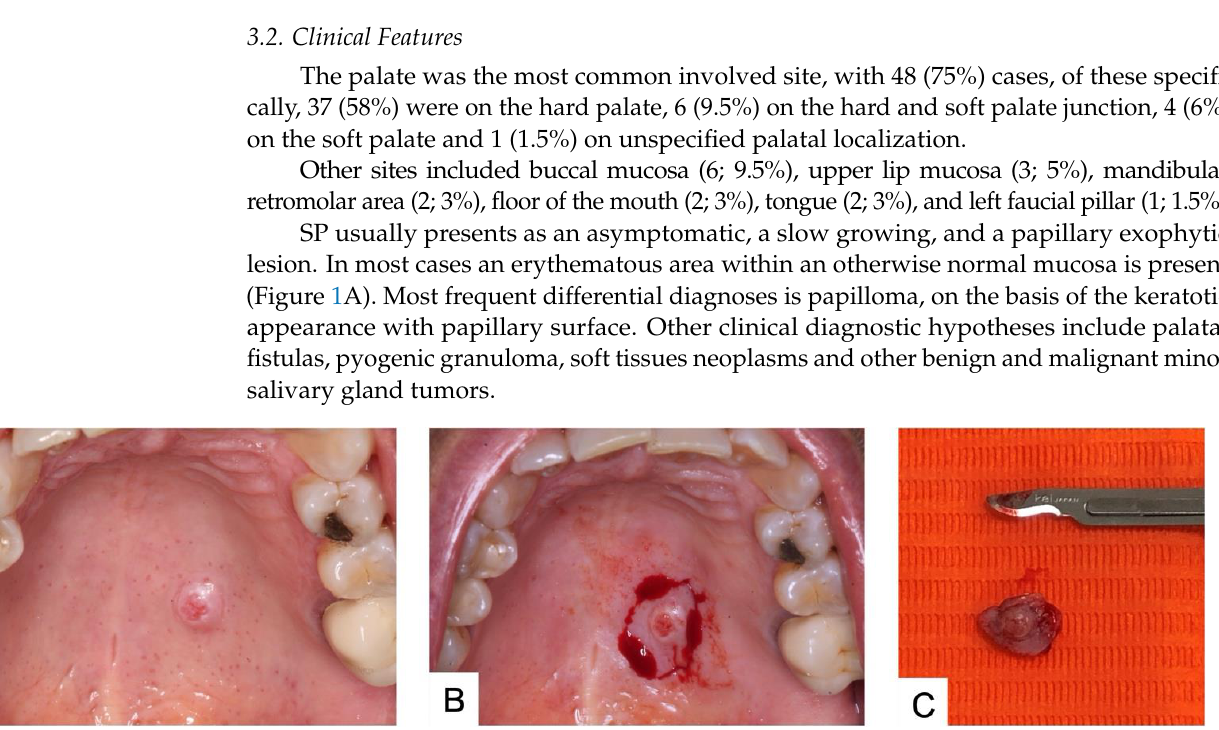
Figure 1. ( A ) Sialoadenoma papilliferum on the hard palate of a 48-year-old female patient; ( B ) Sur- gical excision under local anesthesia; ( C ) Surgical specimen. ( B ) Surgical excision under local anesthesia; ( C ) Surgical